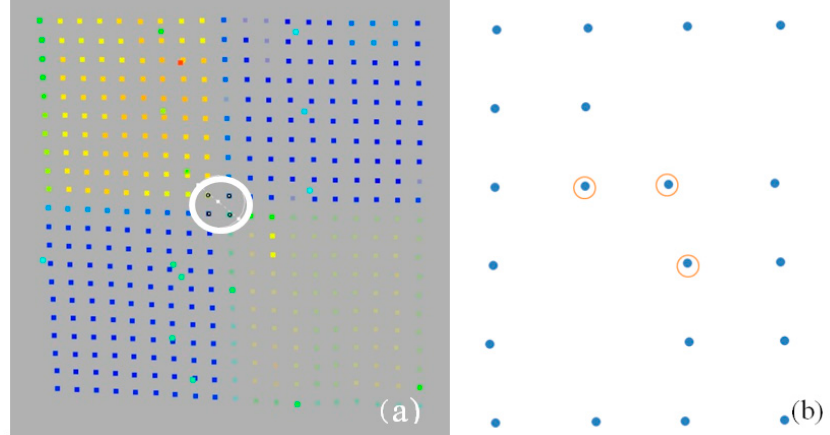
Figure 9. Examples of the “inner extreme points” of the target point cloud ( a ) regular points; ( b ) irregular and missing points.